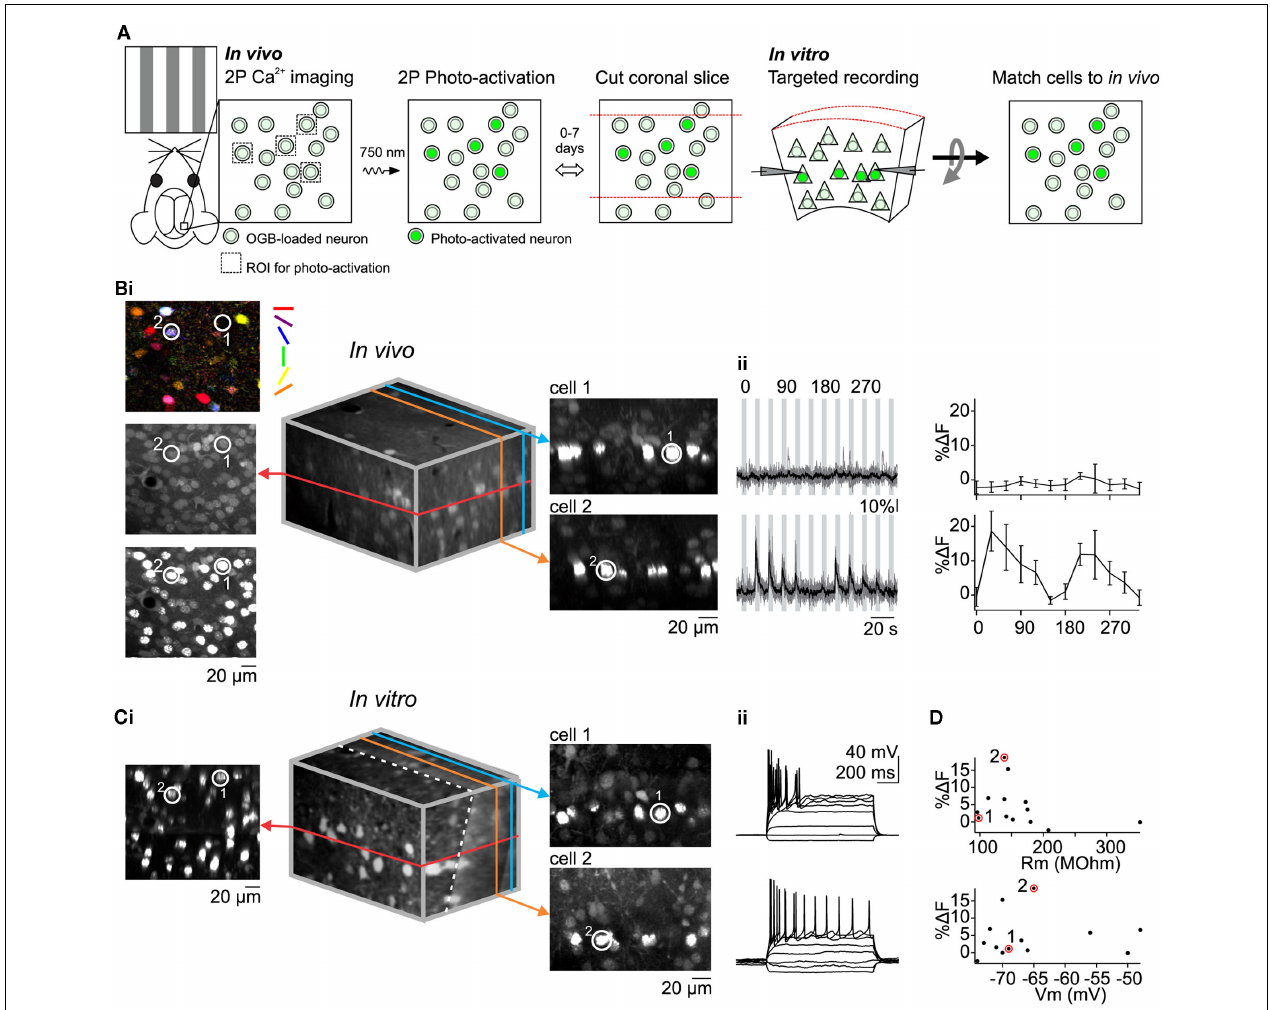
register with the in vivo stack.The dotted white line denotes the slicing angle (i.e., main plane of the slice) and the red line denotes the optical section containing the cells that were photo-activated in vivo . Note that the in vivo (red) optical section is not exactly perpendicular to the plane of the slice [ (i) , right] XZ optical sections containing cells 1 and 2. Note the correspondence between in vitro and in vivo (B) images. (ii) Membrane potential response of cells 1 and 2 to hyperpolarizing and depolarizing current injection. (D) Magnitude of visual response to gratings is not correlated with input resistance or membrane potential. Size of the visual response to the preferred orientation recorded in vivo is plotted against the input resistance (top) and membrane potential (bottom) recorded in vitro ( n = 13 neurons). Data points corresponding to example cells 1 and 2 are